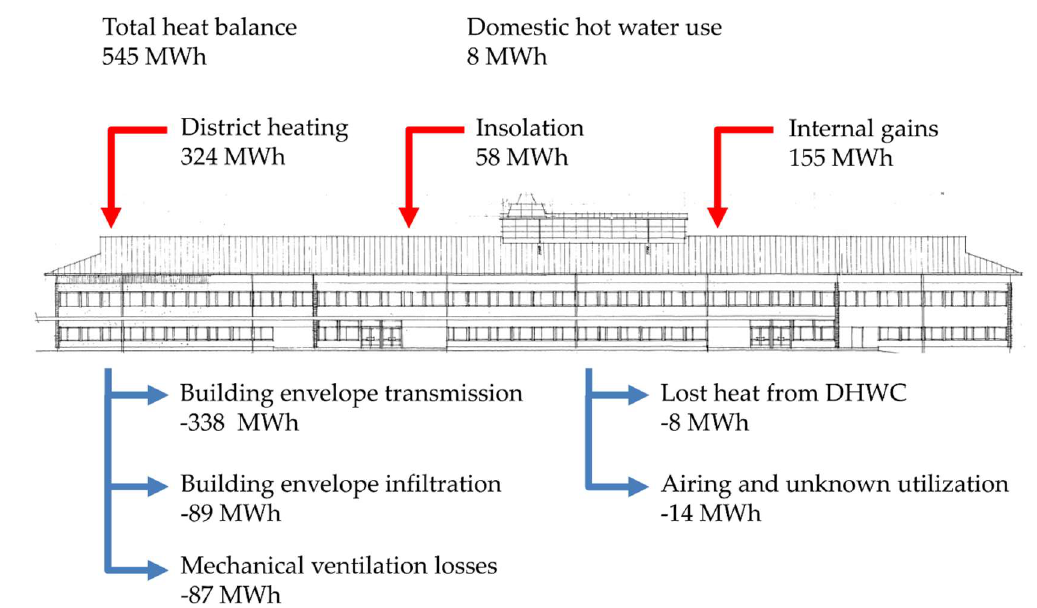
Figure 12. Heat balance of the school building, simulated during heating season, 1 September to 31 May, with normalised climate data.